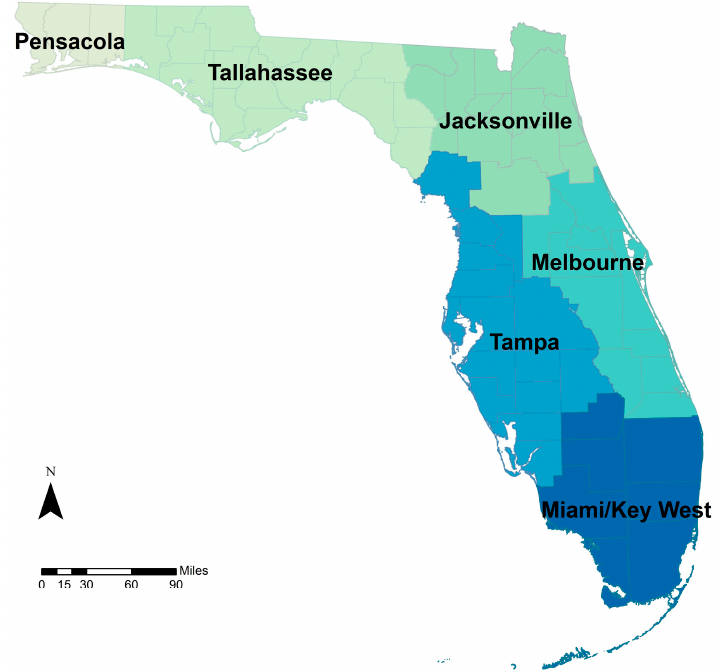
Figure 7. Daily maximum temperatures were determined across six National Weather Service (NWS) regions.